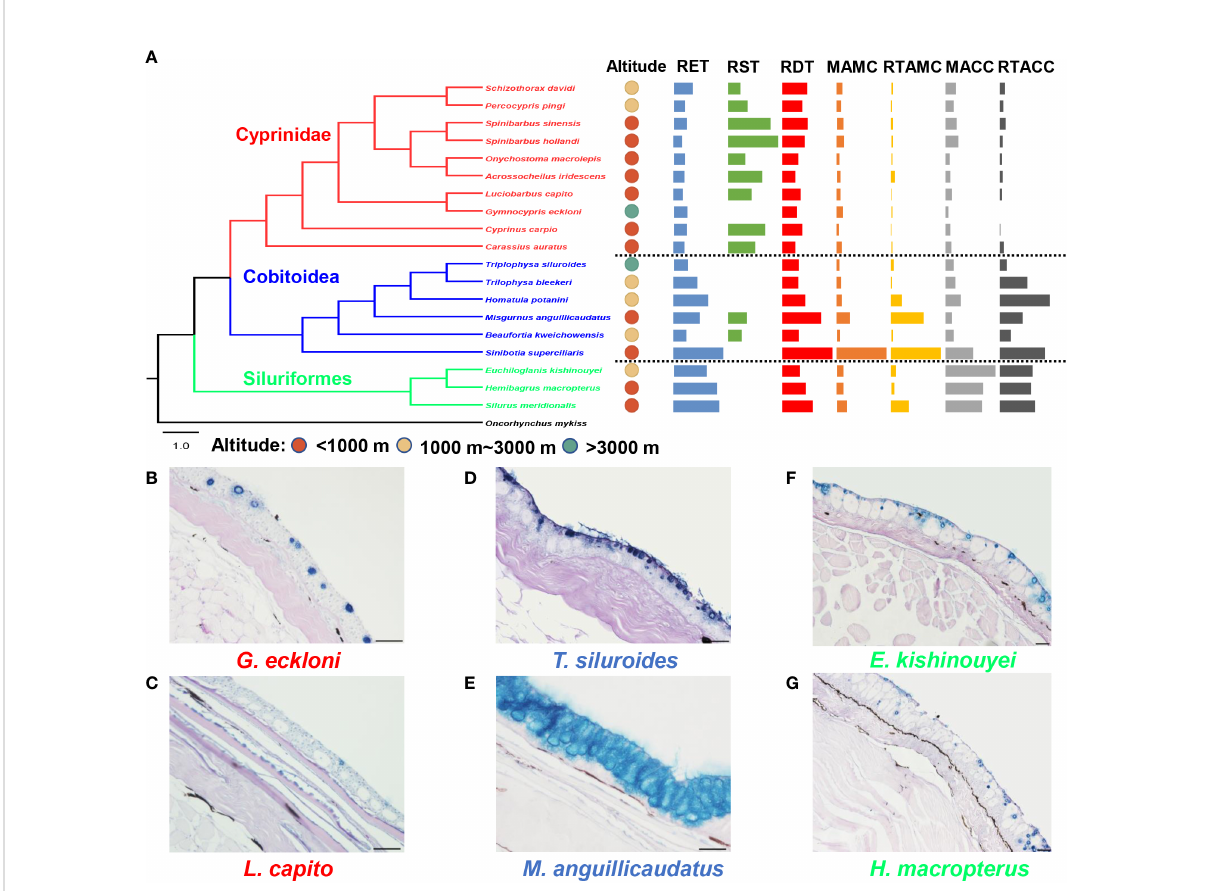
FIGURE 2 Differences in skin histological structure between high-altitude and low-altitude fi shes. (A) The phylogeny, altitude and skin histological indicators (mean, standardized by the maximum) of experimental fi shes. (B – G) The skin histological structure of three representative high- altitude fi shes and their low-altitude relatives. The scale is 50 m m. RET, the relative epidermal thickness; RST, the relative scale thickness; RDT, the relative dermal thickness; MAMC, the mean area of mucus cells; MACC, the mean area of club cells; RTAMC, the relative total area of mucous cells; RTACC, the relative total area of club